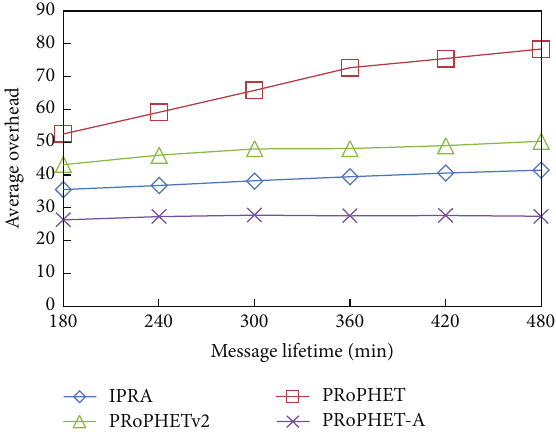
Figure 9: Average delay (AD) versus buffer size.